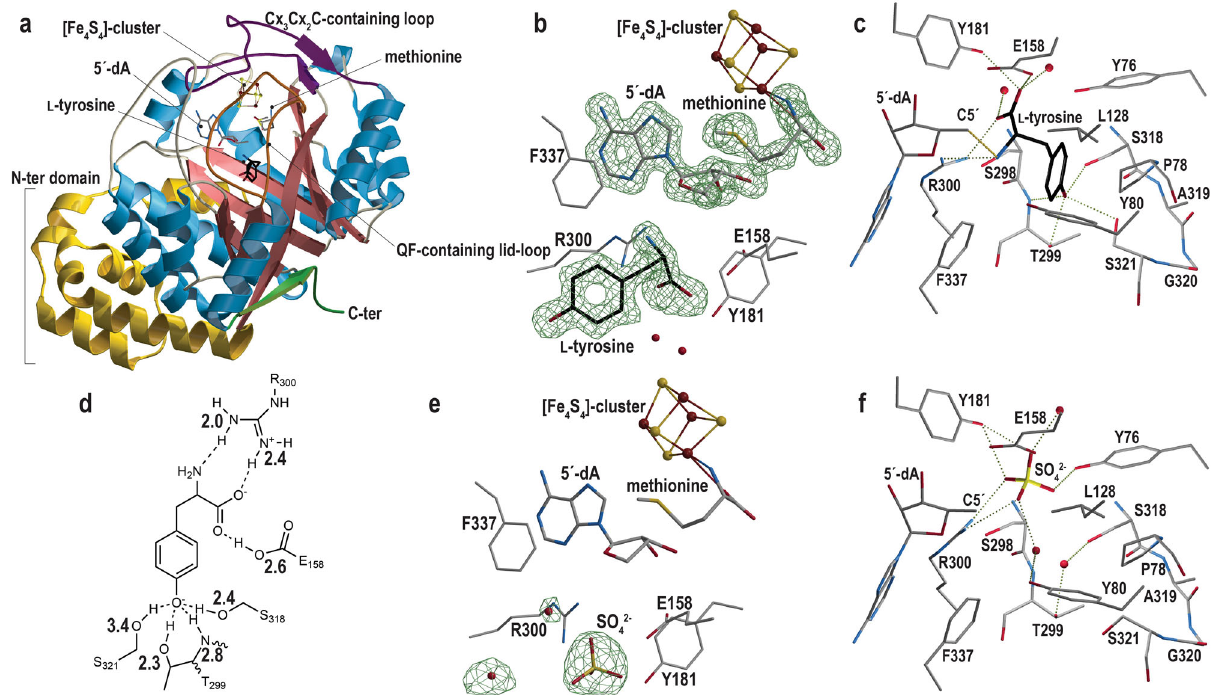
Fig. 2 Crystal structure of Tc ThiH. a Overall structure of ThiH where the radical SAM core is depicted in indian red ( β -strands) and blue ( α -helices). The N- and C-terminal stretches are depicted in gold and green, respectively. The CX 3 CX 2 C-motif containing loop and the additional β -sheet are represented in purple. The [Fe 4 S 4 ]-cluster is depicted in ball-and-stick while 5´-dA, the L-methionine bound to the [Fe 4 S 4 ] cluster and L-tyrosine are represented as sticks. C, N, O, S and Fe atoms are represented in light gray (dark gray for L-tyrosine), blue, red, yellow and brown, respectively. b Zoom of the L-tyrosine Tc ThiH binding site. The Fo − Fc difference Fourier (omit) electron density map for 5´-dA, L-methionine and L-tyrosine is contoured at 4.5 σ and depicted as green mesh (cover radius 2.0 Å). Atoms are represented and colored as in ( a ). c Substrate (L-tyrosine) binding mode at the Tc ThiH active site. Atoms are represented and colored as in ( a ). The 2 Fo − Fc electron density map of L-tyrosine, that is not shown here to visualize the substrate ’ s interactions with the protein, can be found in Supplementary Fig. 4a. d Scheme of interactions between the L-tyrosine and the Tc ThiH active site; Distances in Å (X-ray model, molecule A), between the heavy atoms of the protein and those of the substrate, are indicated at the protein atoms for clarity. The atomic coordinate errors have been estimated to 0.036 Å for all the L-tyrosine heavy atoms (0.046 Å for the overall structure) using the Online_DPI server 56 . e Zoom of the substrate-free Tc ThiH active site in the same orientation as in ( b ) (see main text). The Fo − Fc difference Fourier (omit) electron density map surrounding the sulfate ion and the water molecules is contoured at 3 σ and depicted as green mesh (cover radius 2.0 Å). f Substrate-free Tc ThiH active site in the same orientation as in ( c ). Stereoviews of ( b , c , e , f ) are depicted in Supplementary Figs. 4b, 5, 6 and 7, and corresponds to a full ( βα ) 8 triose-phosphate isomerase-like fold fl anked by N- and C-terminal stretches (Fig. 2a). Residues 1 – 71 de fi ne a compact α -domain (in gold in Fig. 2a) similar to that